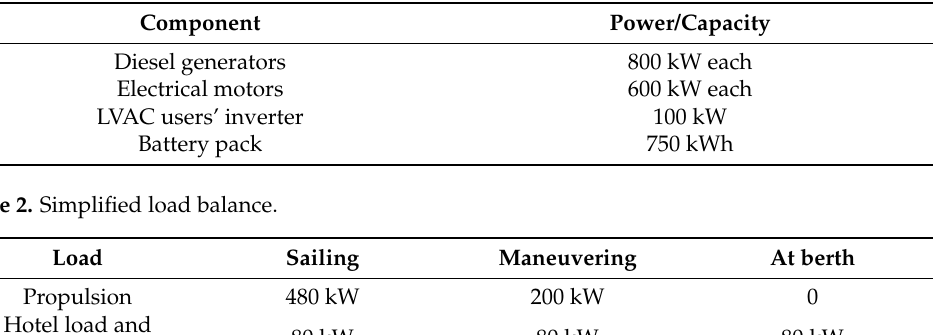
Table 1. Main data of the bidirectional ferry power system.